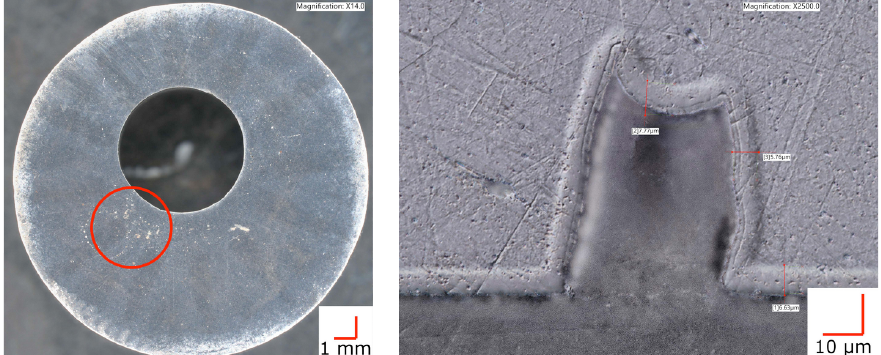
Figure 5. Plan- and cross-sectional view of a sample of AM-SRA-LTNC Alloy 22. In the area of the red circle, the plan view appears to have an ≈ 40 µ m-diameter pit. The cross-section on the right reveals that this actually is an internal void. LTNC-SRP has produced a conformal carbon-rich subsurface zone around the